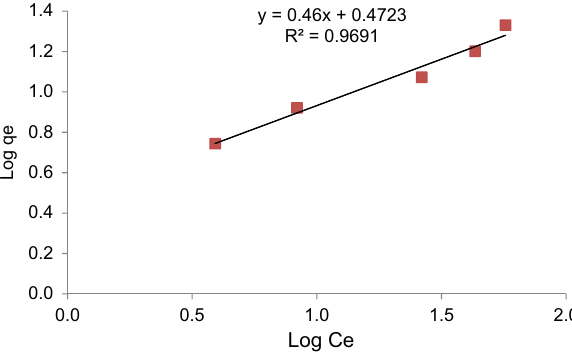
Fig. 6 Freundlich adsorption isotherm plot of Cd (II) ion onto UMSFS biomass